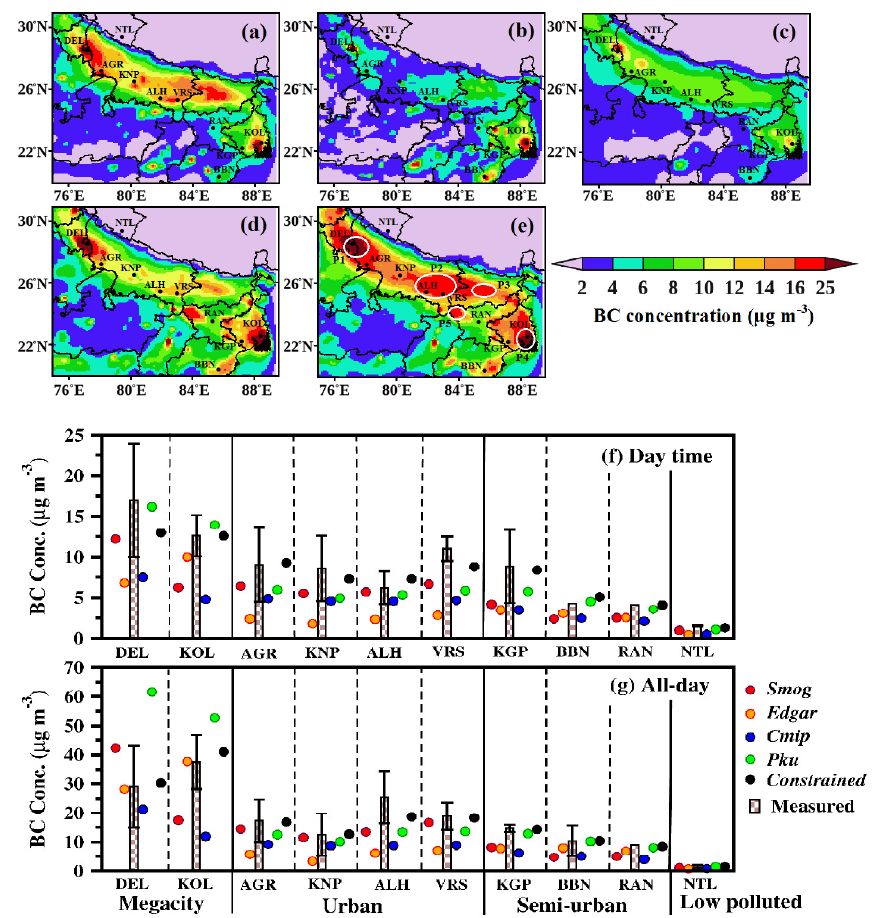
Figure 3. (a–e) Spatial distribution of simulated winter monthly mean BC surface concentration from the simulations (a) Smog, (b) Edgar, (c) Cmip, (d) Pku, and (e) Constrained; the circles in white in (e) represent the hotspots with patches of high BC concentrations. P1: Delhi patch, P2: Prayagraj–Allahabad–Varanasi patch, P3: Patna patch, P4: Kolkata patch, P5: Palamu patch. (f–g) Comparison of simulated monthly (f) daytime and (g) all-day mean BC surface concentration from five simulations with measurements at respective stations under study over the IGP; error bars represent the standard deviation (1 σ ) in the measured BC